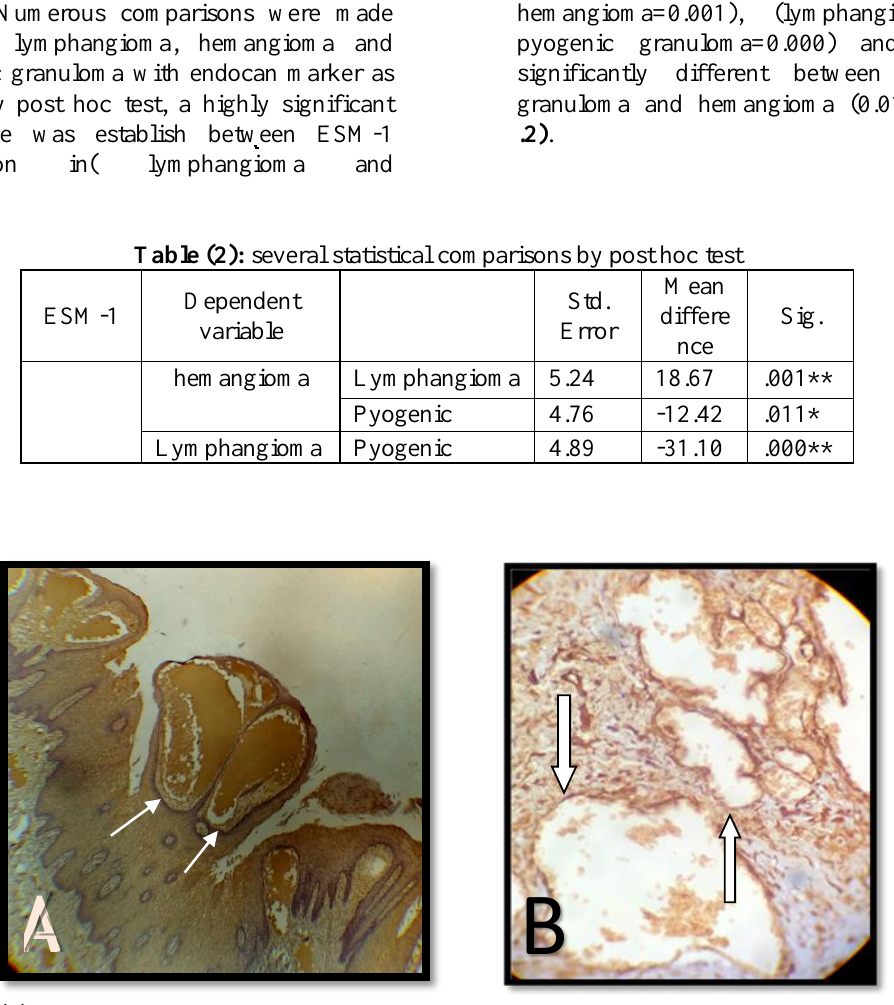
Figure (1) A: Photomicrograph in lymphangioma showing ESM-1 immunostaining - negative stain lymphatic vessels and positive blood vessels X100) B: Positive blood vessels X400) (thin arrow for lymphatic while, thick arrow for blood